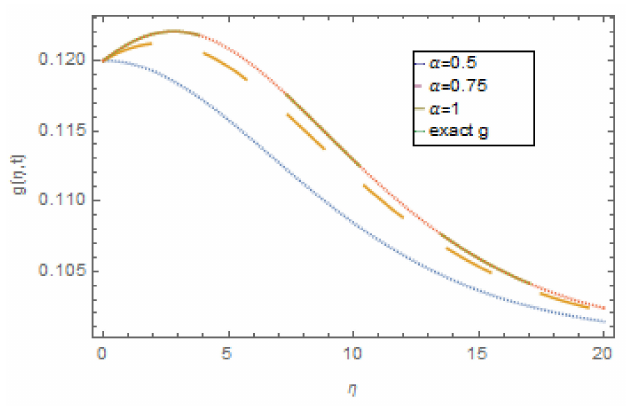
Figure 13. 2D plot of comparison of